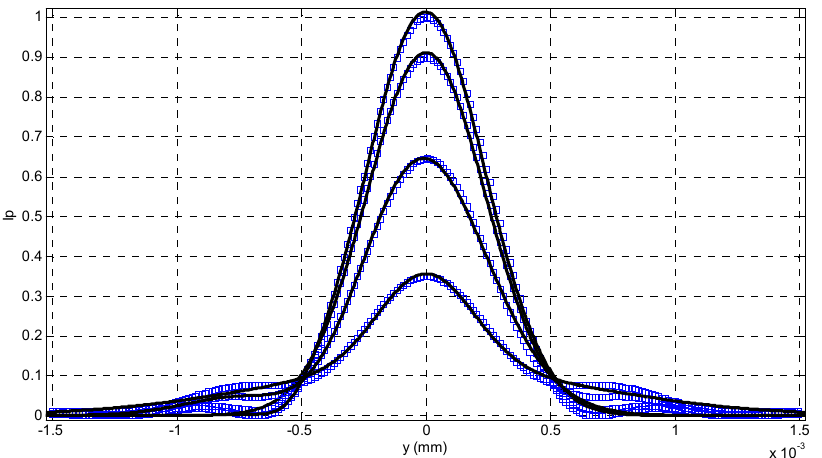
Figure 3. The fitted Gaussian curves with different depth variations.